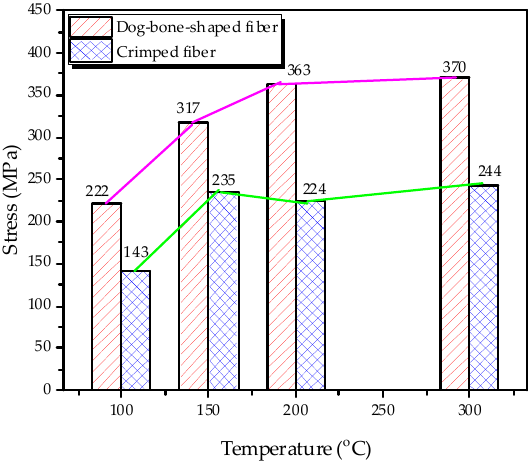
Figure 2. Comparison maximum recovery stress of the fibers. Pullout behaviors of the fibers were also shown in Figure 3. For the dog-bone-shaped fiber, it got the maximum pullout force at the slip of about 0.1–0.3 mm, which was very small in comparison with the total slip. When being heated, the fiber’s diameter was bulged; thus, the additional frictional bond was developed due to the confining pressure induced by the bulging. The additional frictional bond and the end anchoring increased the pullout resistance resulting in that the slip at the peak pullout force moved to about 6 mm. For crimped fiber, the shape of the responsive pullout force-slip curve was a look-a-like of the wave with the wavelength that was nearly equal to the step of each indentation of the crimped fiber. The pullout force of crimped fiber was relatively high; the maximum values were about 550 N and 520 N in non-heating and heating cases, respectively. The peak of the pullout force was at the peak of the crimped part of the fiber in both cases of heating treatment. 1:1:0.15:0.35:0.009. The mortar for the cyclic test did not use water-reducing admixture; however, the volume fraction of fly ash was increased equally with that of Portland cement type I and silica sand. Thus, the water was increased to 0.698 by the weight ratio. Table 1 summarized the mixture composition of mortar matrix in two cases.